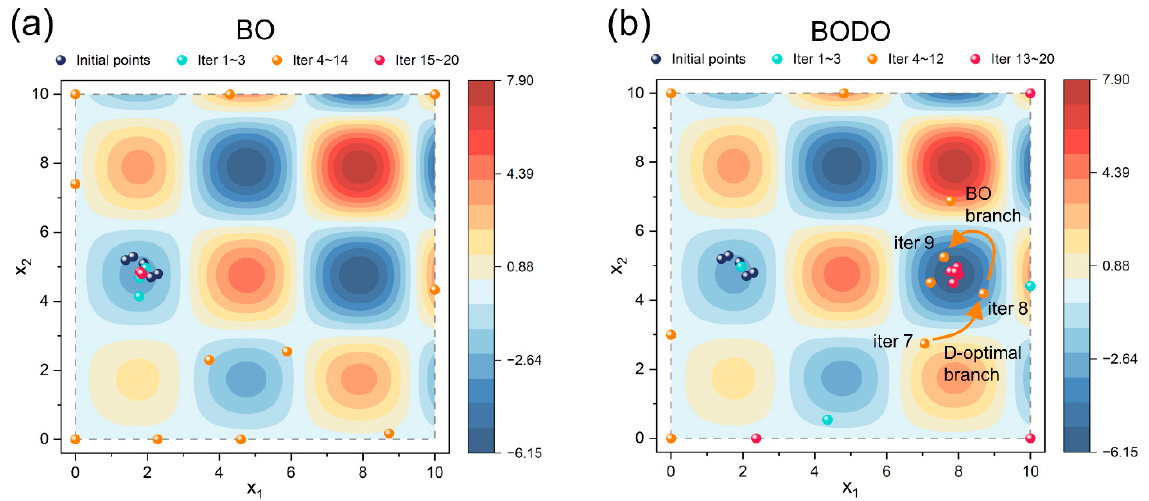
Figure 2. Visualized optimization processes of BO ( a ) and BODO ( b ) on the 2-dimensional alpine2 function (alpine2 2d ) with the same preset bad-quality initial points. The hyperparameters ε 1 , ε 2 , and β are set to 0.6, 0.4, and 0.95, respectively. Points of different iteration segments are indicated with different colors.